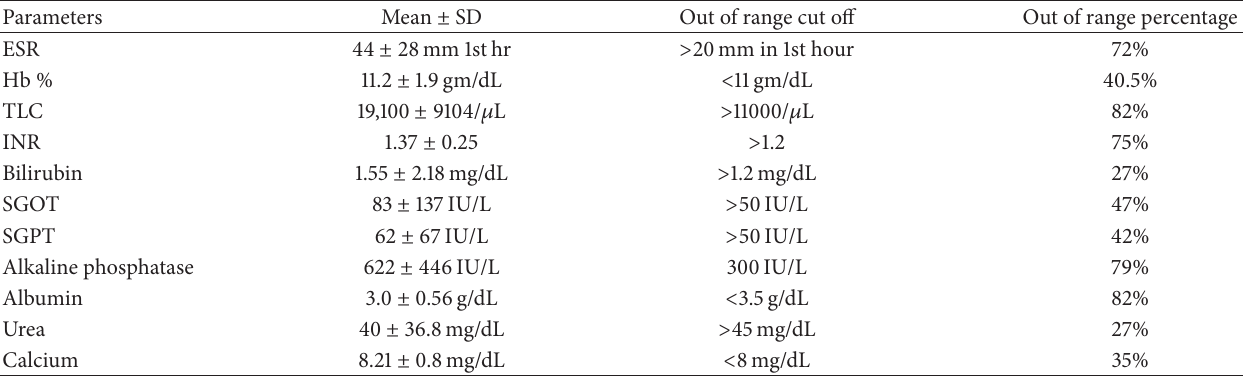
Table 2: Laboratory investigations: all parameters, particularly those related to liver were deranged in good percentage of patients. Sepsis indicators like raised TLC and low albumin were present in more than three-fourths of patients.